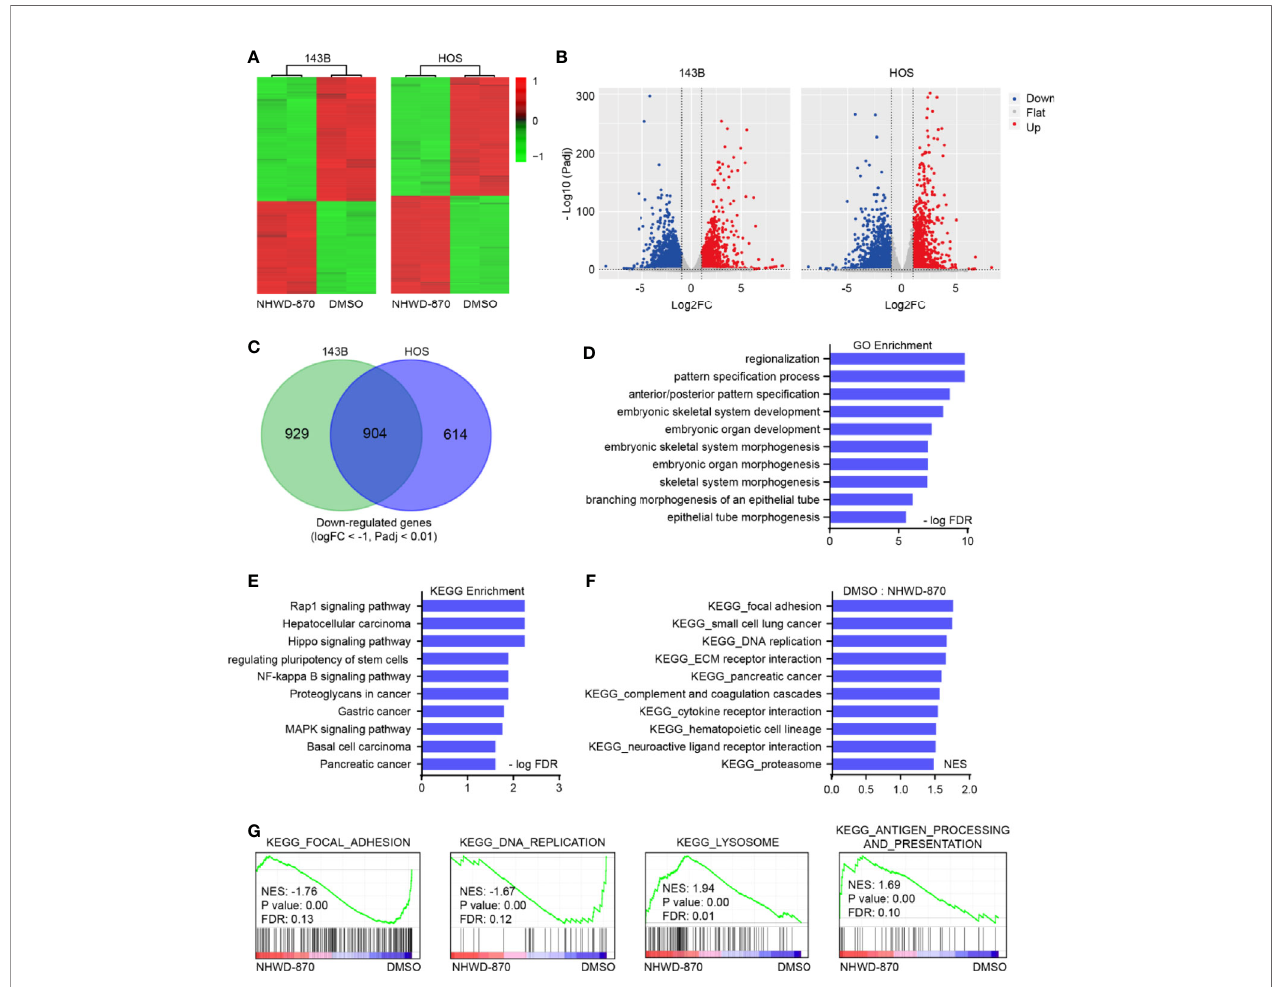
FIGURE 2 | NHWD-870 reverses oncogenic signature in osteosarcoma. (A) Heatmap of differentially expressed genes (log2FC<-1, log2FC<-1, and adjusted p value < 0.01) in 143B and HOS cells treated with NHWD-870 (1 m M for 24 hours) versus DMSO. (B) Volcano plot showing the differentially expressed genes (DEGs) between the NHWD-870-treated and DMSO groups. (adjusted p value < 0.01). (C) Venn diagram of the signi fi cantly downregulated transcripts in 143B and HOS osteosarcoma cells treated with 1 m M NHWD-870 for 24 hours. (D) GO analyses of the 904 overlapping signi fi cantly downregulated genes. The top 10 hits in each category were presented. (E) KEGG analyses of the 904 overlapping signi fi cantly downregulated genes. Top 10 hits in each category were presented. (F, G) GSEA showing enrichment of gene sets in DMSO- or NHWD-870-treated 143B cell